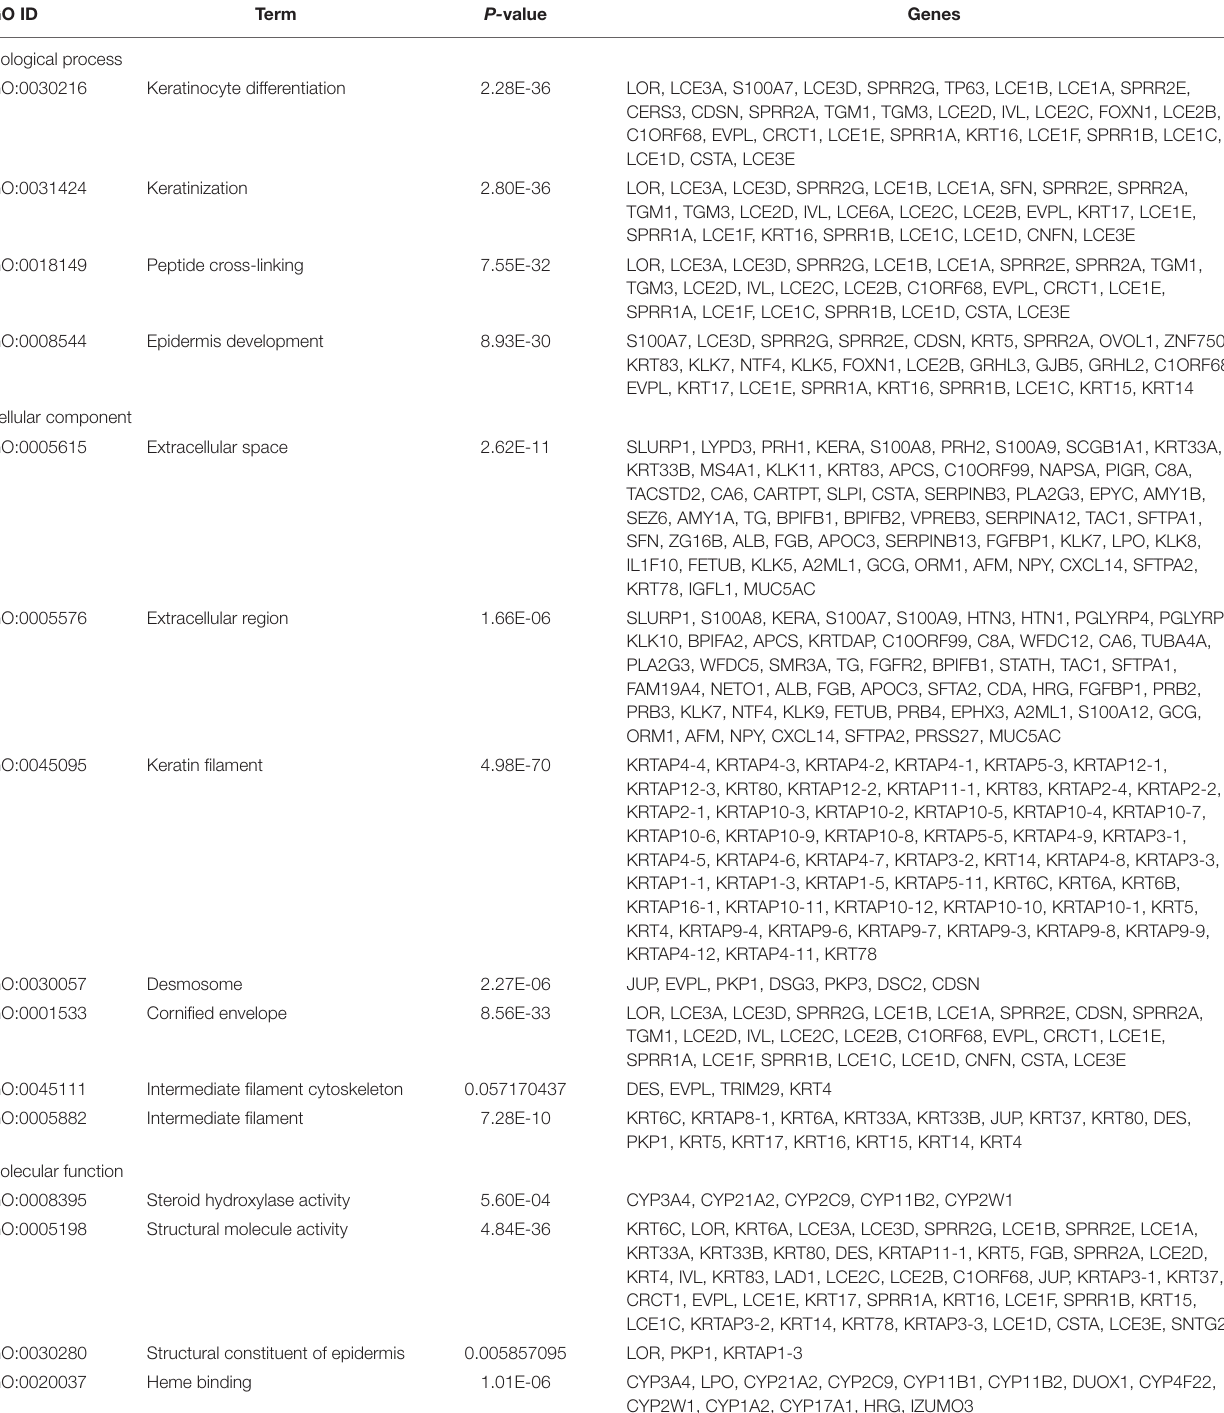
TABLE 3 | GO term enrichment of dysregulated DEGs in co-expression network coexisting in David, GOEAST, Gene Ontology, and PANTHER. GO ID Term P- value